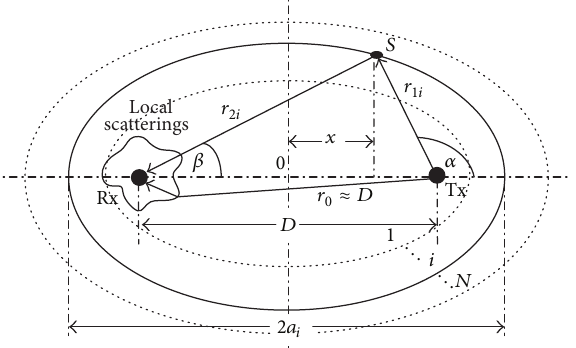
Figure 1: Geometry of the analyzed